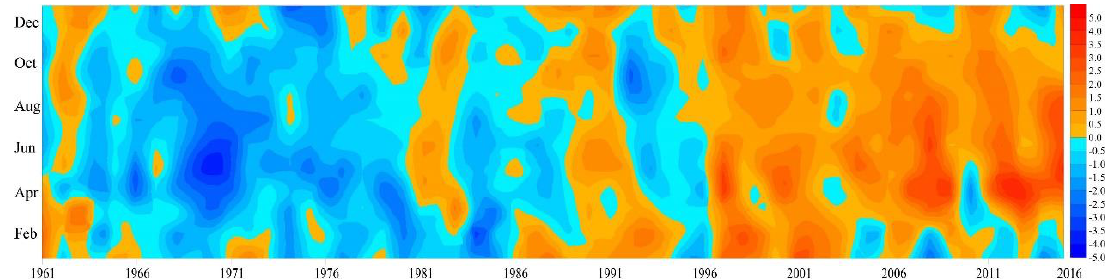
Figure 4. Variations in the monthly soil temperature anomaly (°C) during the period 1961–2015 observed by CMA in the SAM.